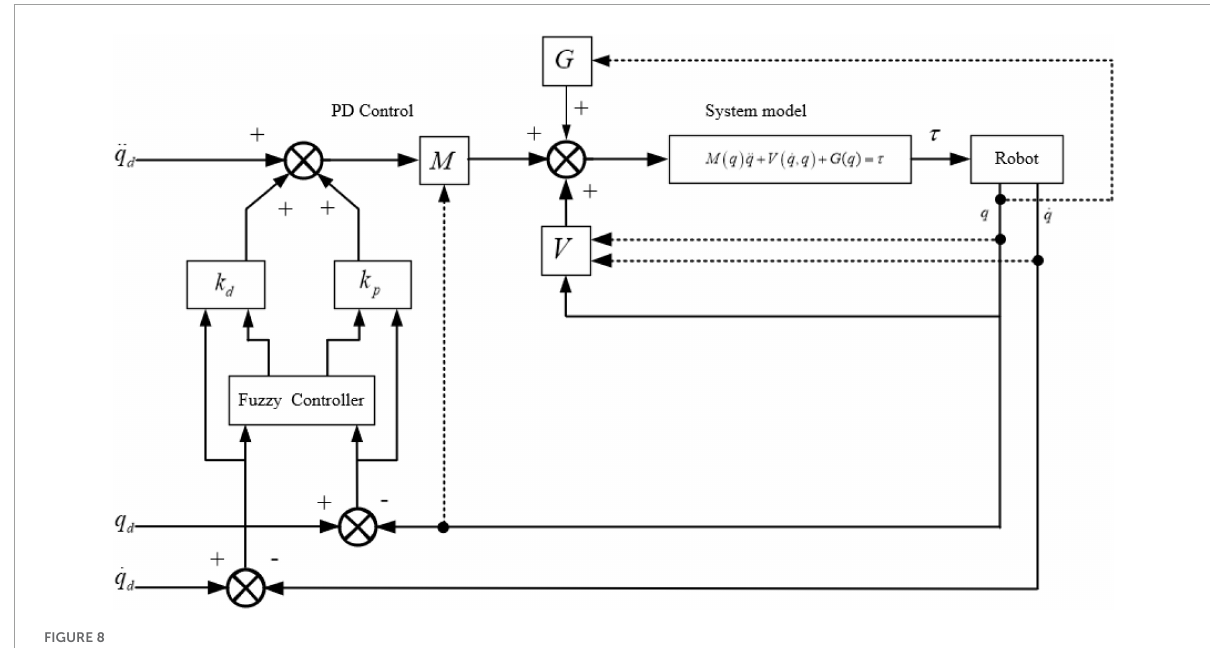
FIGURE8 Fuzzy Proportion Differentiation (PD) control block diagram.